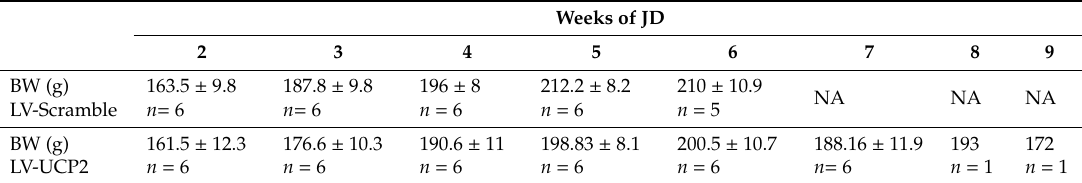
Table 1. Body weight (BW) in Japanese style hypersodic diet (JD)-fed stroke-prone spontaneously hypertensive (SHRSP) rats receiving a single i.c.v. injection of either lentiviral vector encoding UCP2 (LV-UCP2) or empty vector